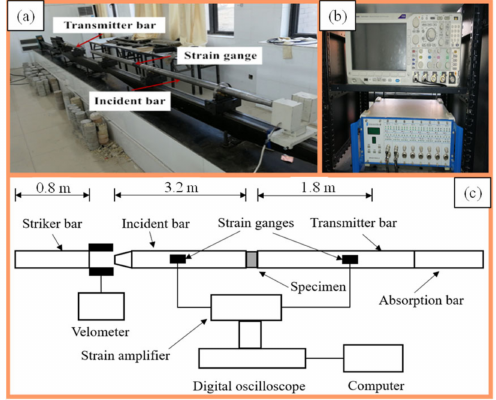
Figure 5. SHPB test device system. ( a ) Test equipment; ( b ) Monitoring equipment; ( c ) Test